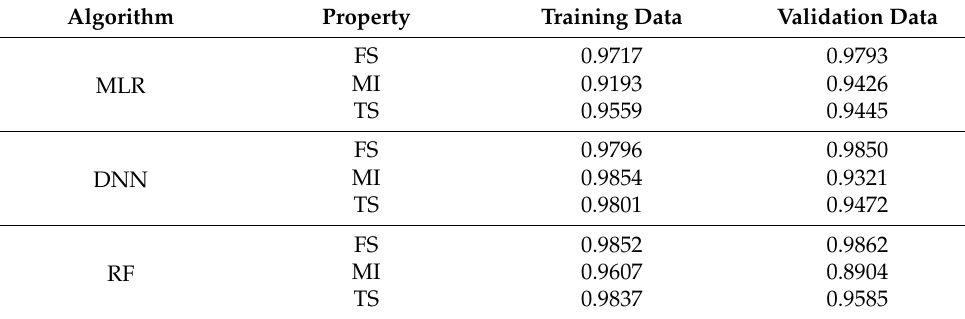
Table 6. Values of the hyperparameters set for DNN and